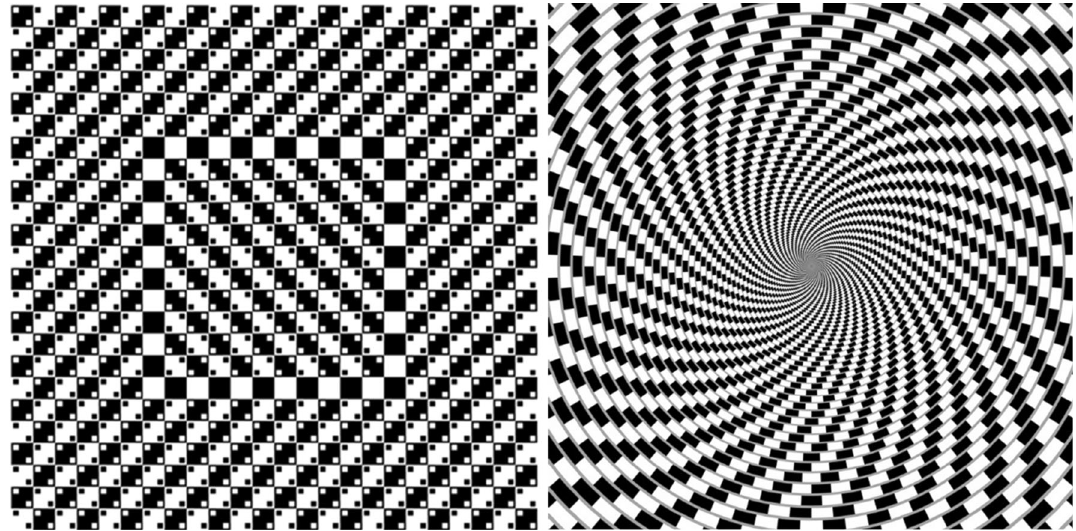
Fig. 1 Sample Tile Illusion patterns. Left Trampoline pattern [70], right Spiral Cafe´ Wall illusion